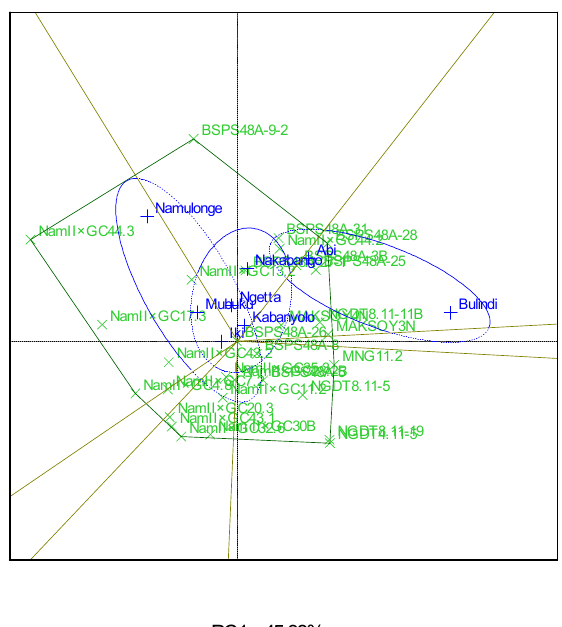
Figure 7. Polygon views of the GGE biplot based on the symmetrical scaling for the “which-won- where” pattern of 30 soybean genotypes evaluated in eight locations and six seasons. The GGE scatterplot showed that Bulindi was the most discriminating environment, while Iki-Iki was the least of the eight locations (Figure 8). This was revealed by the long and short environment vectors of Bulindi and Iki-Iki, respectively. Bulindi was the most representative of the mega-environment of all the eight test environments compared to the rest due to the small angle from the average environment axis (Figure